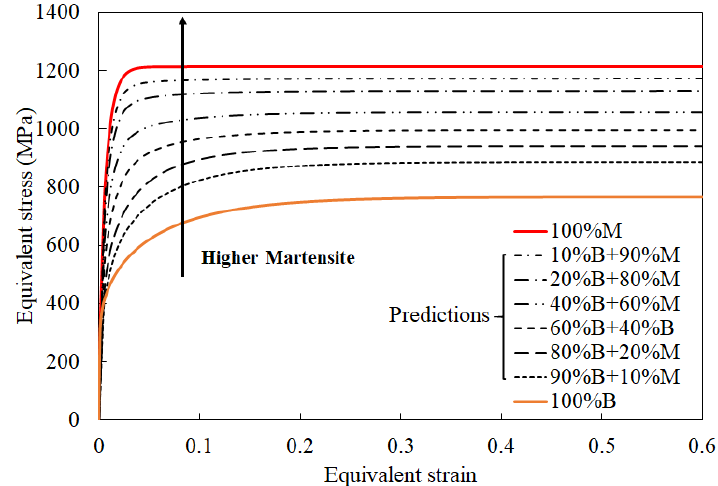
Figure 18. The predicted hardening curves for Ductibor ® 1000-AS bainitic-martensitic microstructures with various phase amounts (%v) using the established numerical scheme. The 100%B and 100%M hardening curves are also displayed for the reference.